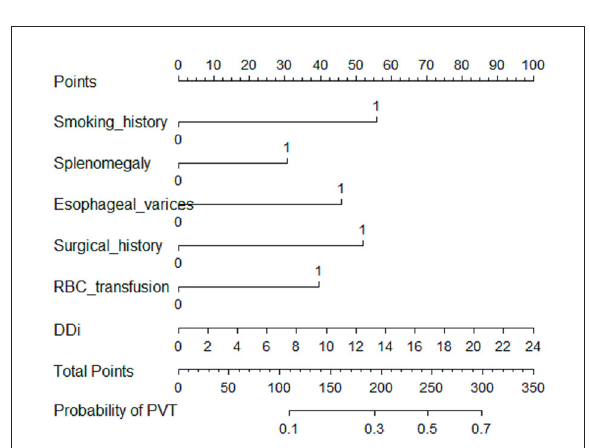
FIGURE2 Nomogram for predicting PVT in patients with cirrhosis. In the nomogram, a corresponding score was assigned to each variable on the point scale axis. The sum of all variables located on the total points axis, and then the probability of PVT in patients with cirrhosis was calculated.